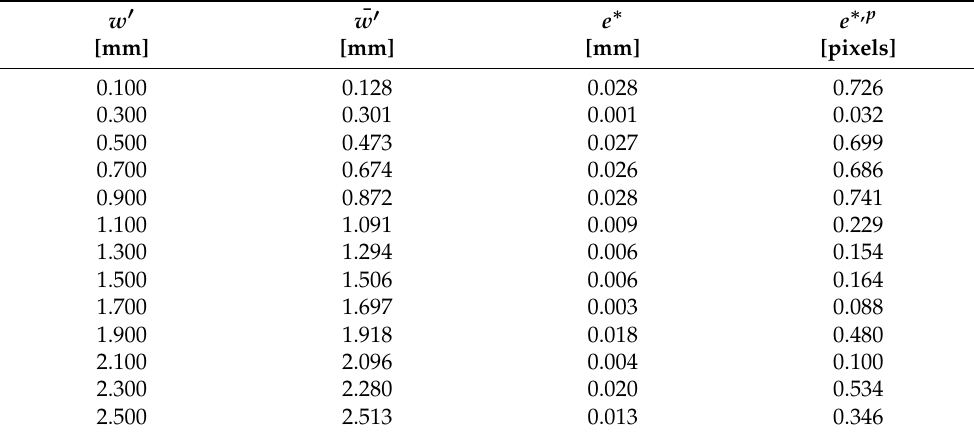
Table 2. Comparisons between the groove width set on the micrometric stage ( w (cid:48) ) and the corre- sponding groove width measured through the proposed vision-based method ( ¯ w (cid:48) ). The absolute error is given in pixels ( e ∗ , p ) and mm ( e ∗